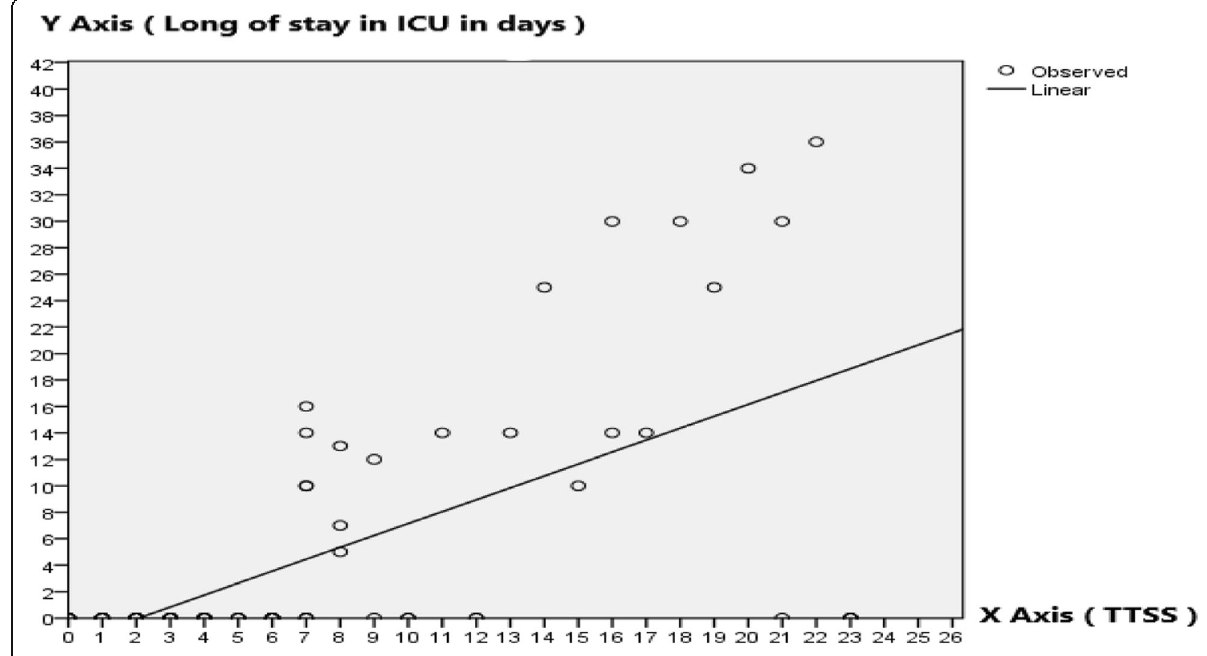
Fig. 2 Regression curve showing the effect of increasing TTSS (X-axis) on the duration of ICU stay (Y-axis). ( p < 0.001)